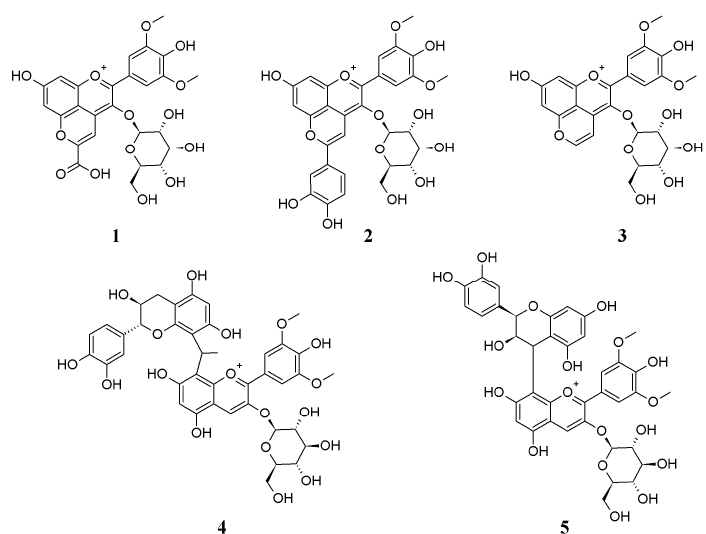
Figure 4. Pigments formed during wine aging: ( 1 ) vitisin A; ( 2 ) pinotin A; ( 3 ) vitisin B; ( 4 ) ethyl-linked catechin-Mv glucoside; ( 5 ) direct-linked catechin-Mv glucoside.